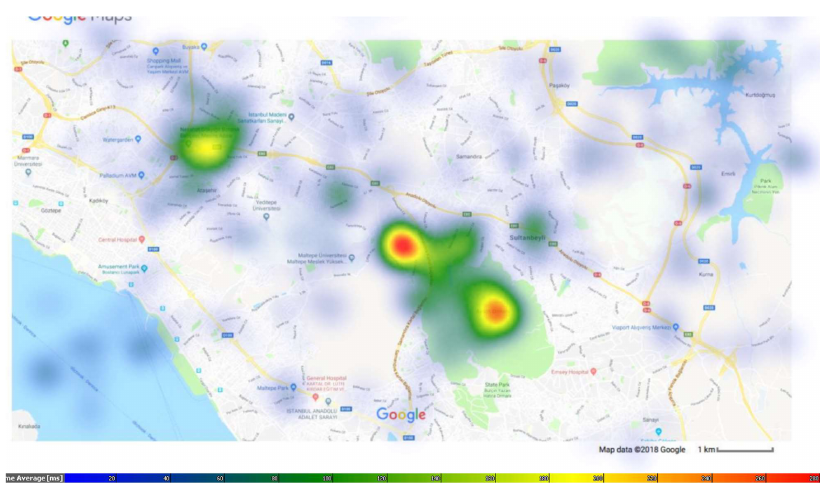
Figure A2. Larger version of Figure 4.